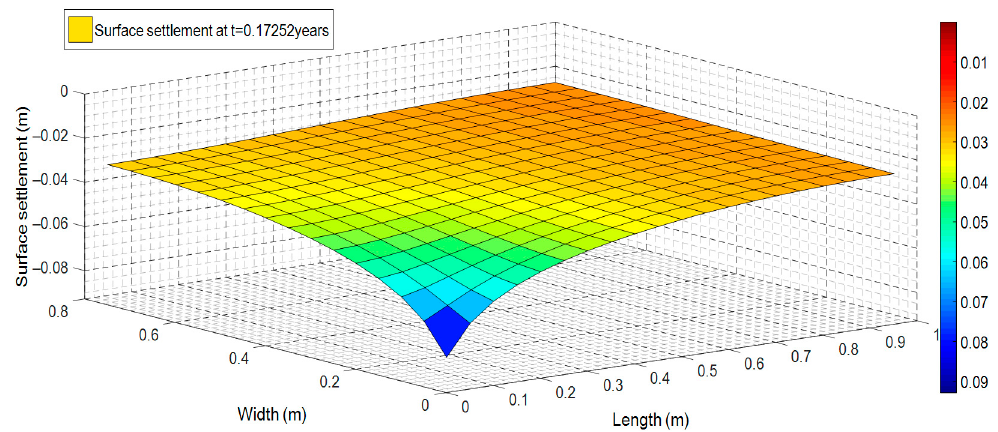
Figure 15. Screenshot of the settlement evolution animation on the ground surface.